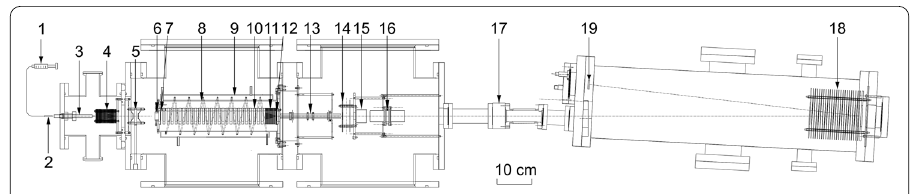
Figure 1 Schematic diagram of the cryogenic IM-MS apparatus. (1) Syringe pump, (2) metal capillary, (3) heated desolvation capillary, (4) ion funnel, (5) quadrupole ion trap, (6) ion lens, (7) entrance aperture of a drift tube, (8) ion drift tube, (9) liquid nitrogen jacket, (10) electrodes for ion-drifting, (11) ion funnel, (12) exit aperture of the drift tube, (13) octopole ion guide, (14) acceleration electrodes of TOF-MS, (15) ion-beam deflector, (16) einzel lens, (17) gate valve, (18) TOF-MS reflectron electrodes, and (19) dual microchannel plate ion detector